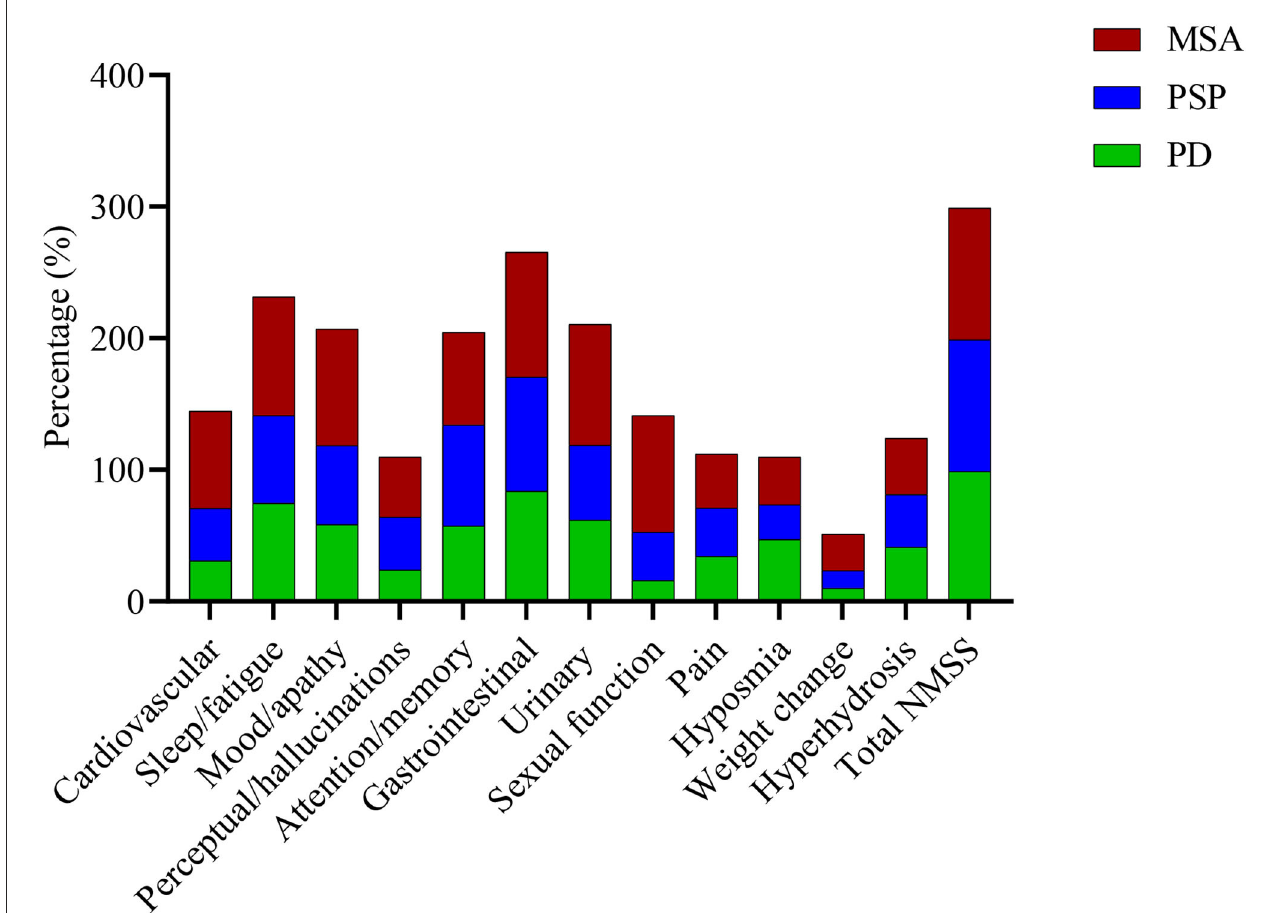
FIGURE1 Frequencies of non-motor symptoms in the MSA, PD, and PSP groups. There were about similar frequencies of total NMSS, attention/memory, and gastrointestinal subdomains symptoms among the three parkinsonian disorders. However, symptoms of the cardiovascular, sleep/fatigue, mood/apathy, urinary, and sexual function subdomains and weight change were more commonly seen in patients with MSA than PD and PSP. MSA, multiple system atrophy; PD, Parkinson’s disease; PSP, progressive supranuclear palsy; NMSS, the non-motor symptom